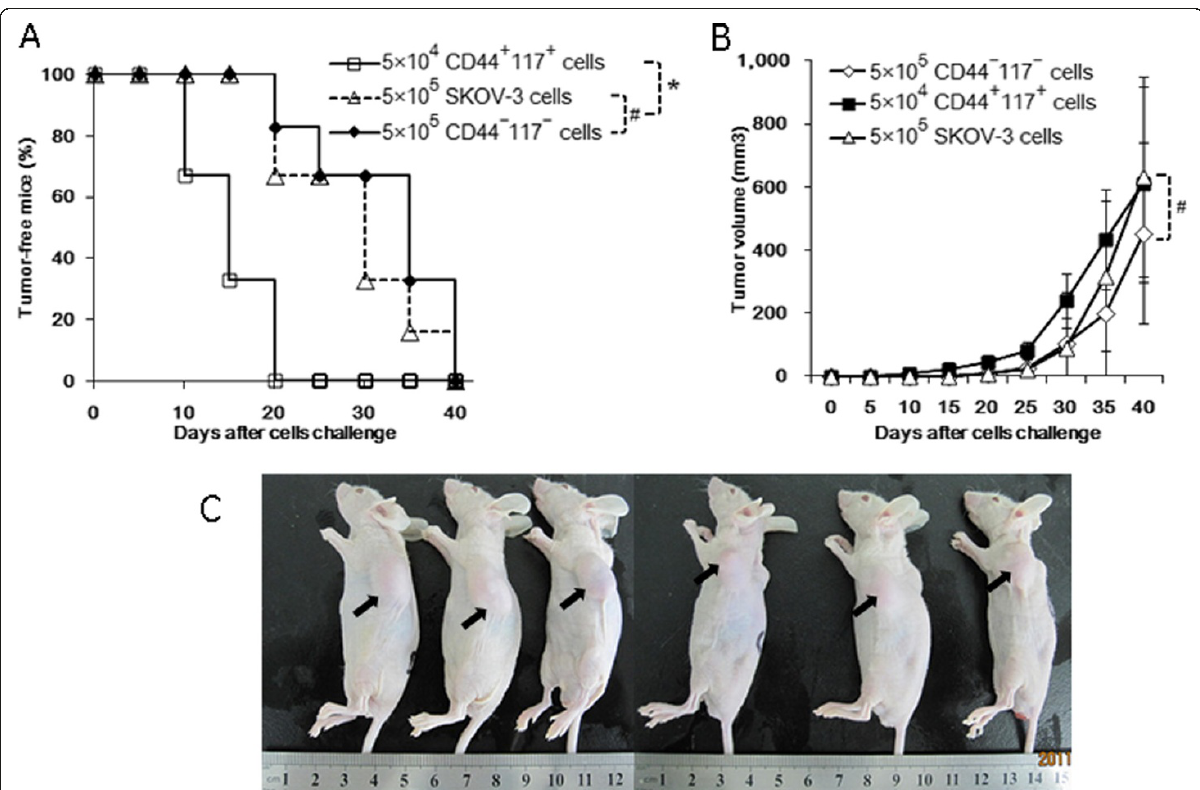
Figure 2 Tumor growth in a xenograft mice injected with the different SKOV3 cells. A shows the oncogenicity in mice s.c. challenged with 5 × 10 5 CD44 − CD117 − cells or SKOV-3 cells or 5 × 10 4 CD44 + CD117 + cells, respectively. B indicates the tumor volume of the mice after being injected with the different SKOV-3 cells. C exhibits the images of tumor-bearing nude mice at 6 weeks after being injected with 5 × 10 4 CD44 + CD117 +